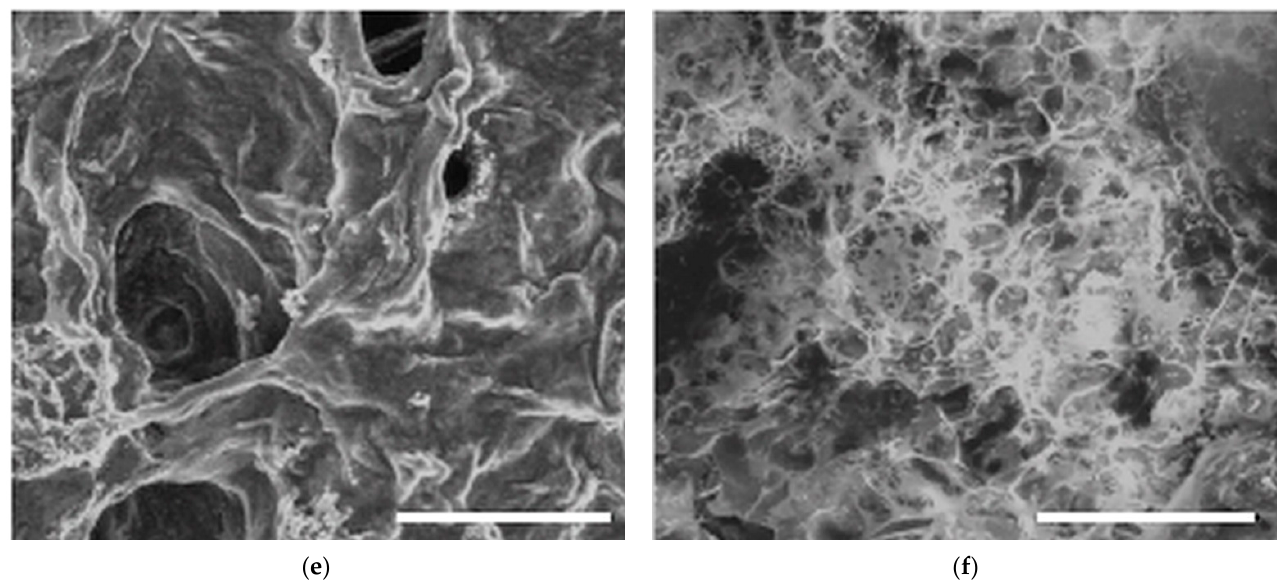
Figure 7. SEM microphotographs for different collagen–based sponges before and after curcumin loading: ( a ) Col LR; ( b ), ( c ) curcumin-loaded Col LR; ( d , e ) CH 10 P 10 -15,2, surface and cross section images; ( f ) CU loaded CH 10 P 10 -15,2. Scale bar: ( a – c ) − 400 μ m; ( d ) − 100 μ m; ( e , f ) − 200 μ m.